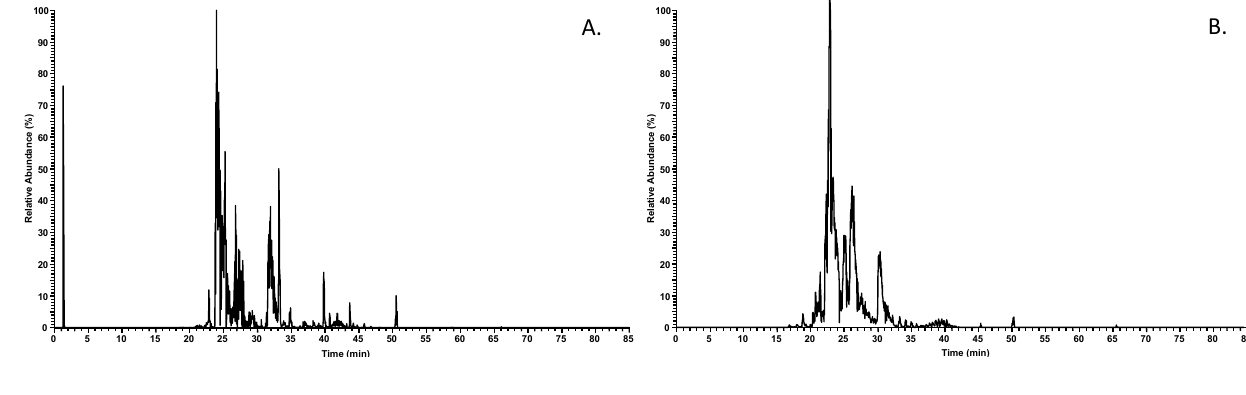
Figure 1. Examples of base-peak chromatograms. ( A ) Base-peak chromatogram of a pooled acquired enamel pellicle (AEP) sample. Peptides generated by trypsinization were loaded on a nanoscale RP-HPLC column, and eluted in a gradient from 5% to 55% buffer B in 65 min. ( B ) Base-peak chromatogram of a pooled AEP sample. Peptides below than 10 kDa were separated by centrifugal filtration and loaded on a nanoscale RP-HPLC column, and eluted in a gradient from 5% to 55% buffer B in 65 min. On the y-axis, the peptide ion peak intensity is